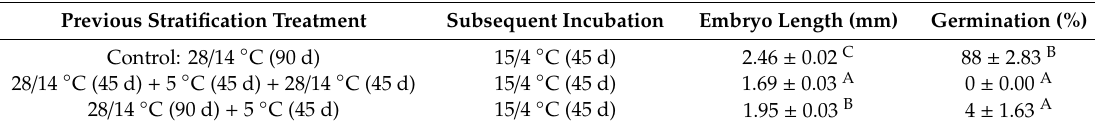
Table 3. Induction of dormancy by cold temperature (5 ◦ C) in N. munozii-garmendiae seeds under light conditions. The seed age at the beginning of the experiment was 0 months. Seeds were collected in 2017. Values followed by di ff erent uppercase letters within a column are significantly di ff erent ( p < 0.05, Tukey’s multiple comparison test).